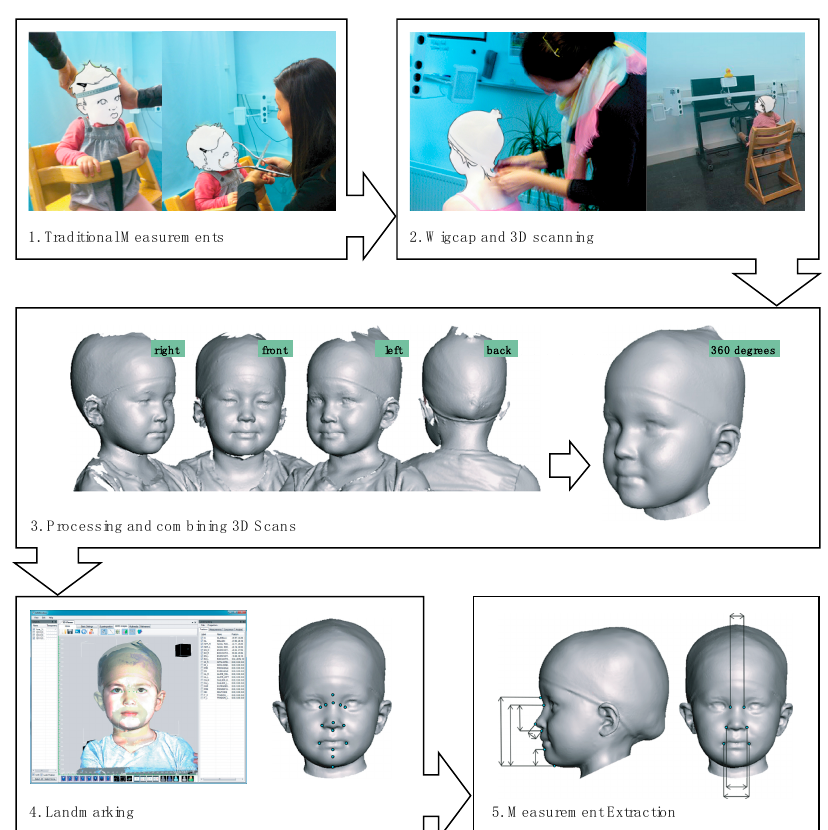
Figure 1. The landmarks included in this study; 1. glabella, 2. sellion, 3. pronasale, 4. subnasale, 5. Sublabiale, 6. Pogonion, 7. menton, 8/9. nasal root point, (right/left), 10/11. endocanthion (right/left),